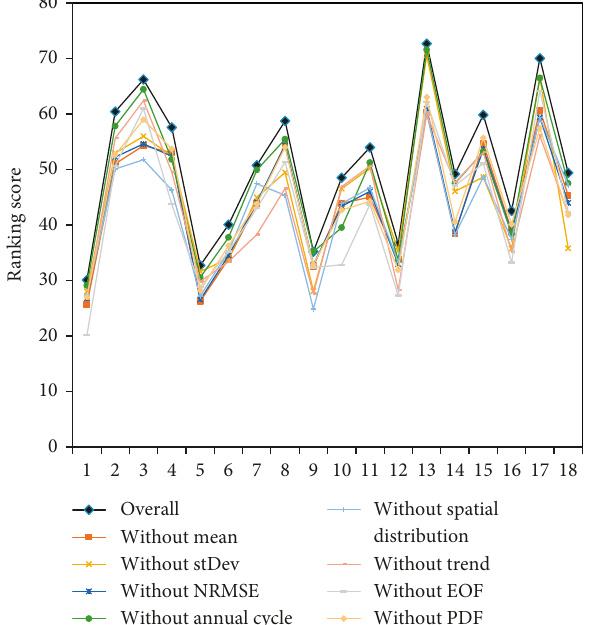
Figure 13: Sensitivity analysis for each individual criterion cor- responding to the sums of the temperature and precipitation